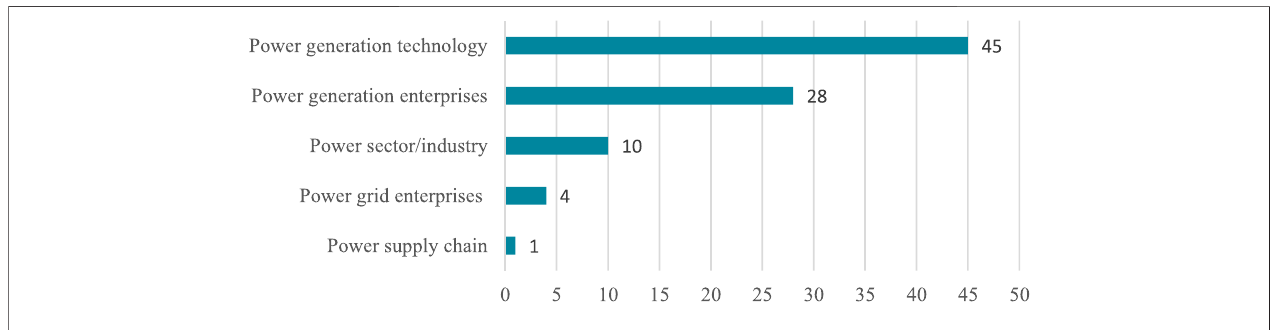
FIGURE 4 | Research subjects ranked by the number of articles.